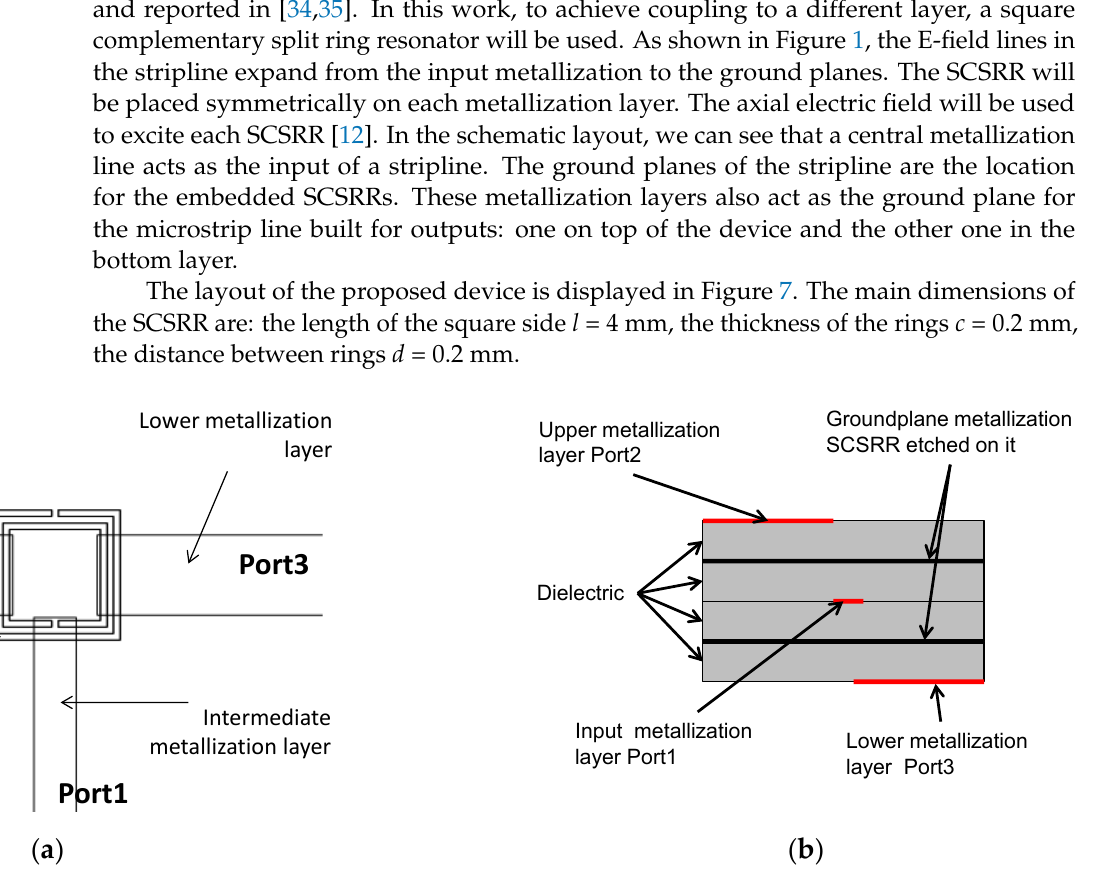
Figure 7. ( a ) Top view of the SCSRR within the power divider. ( b ) Front view of the device. The stripline, which acts as the input, is cut as an opened stub. Both SCSRRs are placed exactly in the same position in top and bottom of this input line. The line is inserted into the rings a distance p1 . In this design, the outputs are placed in each side of the rings without any gap. The currents flowing through the resonator will be coupled to the output lines, which are also designed as open stubs. The distances between the edge of the ring and the end of the output lines are p2 and p3 , respectively, as pictured in Figure 8. For the power divider, the values are p1 = 0.7 mm, p2 = 0.7 mm, and p3 = 0.7 mm.